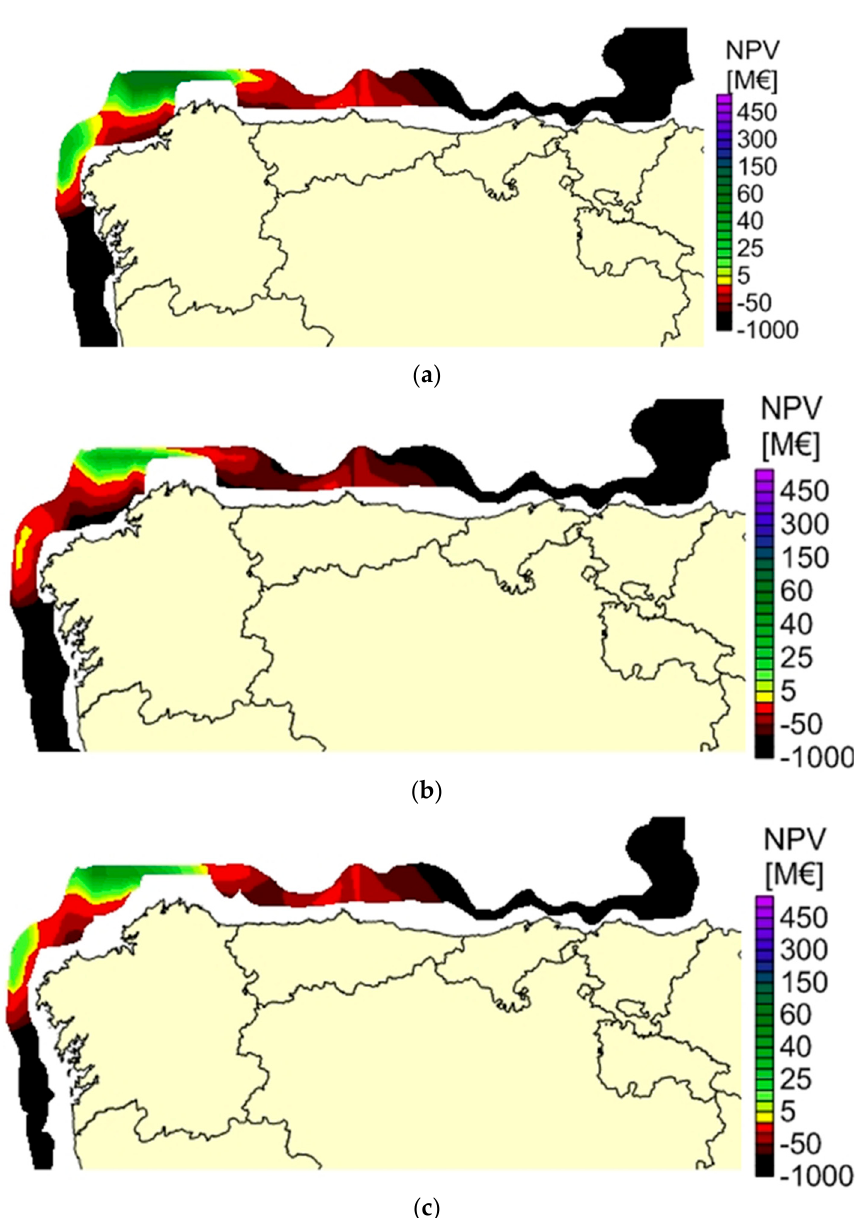
Figure 13. Results for net present value (NPV) considering a tariff of 200 €/MWh and the bathymetry restriction for semisubmersible ( a ), tensioned leg platform ( b ), and spar ( c ).